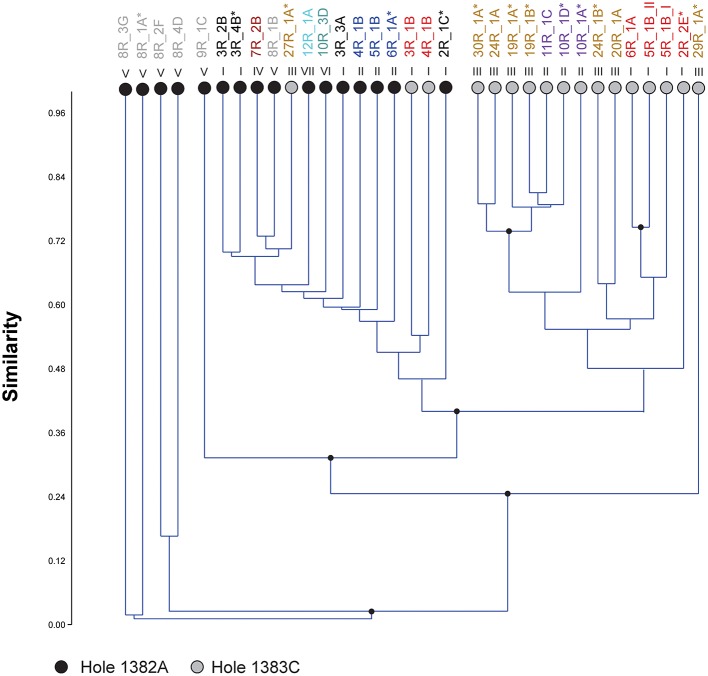
Microbial community clustering. Relative abundance of OTUs in each sample was used to cluster the different communities within the crustal samples from North Pond by means of Bray-Curtis distance calculations. Circles at the end of each branch indicates sampling site; gray: Hole 1383C, black; Hole 1382A. Roman numerals above the branches indicate the lithological unit, also indicated by colors in the sample name above. Asterisk indicates presence of microspheres in the wash fluids after last washing. Numbers above sample name indicates clusters supported by high bootstrap values (> 90) and are identical to numbers used in Table 2.